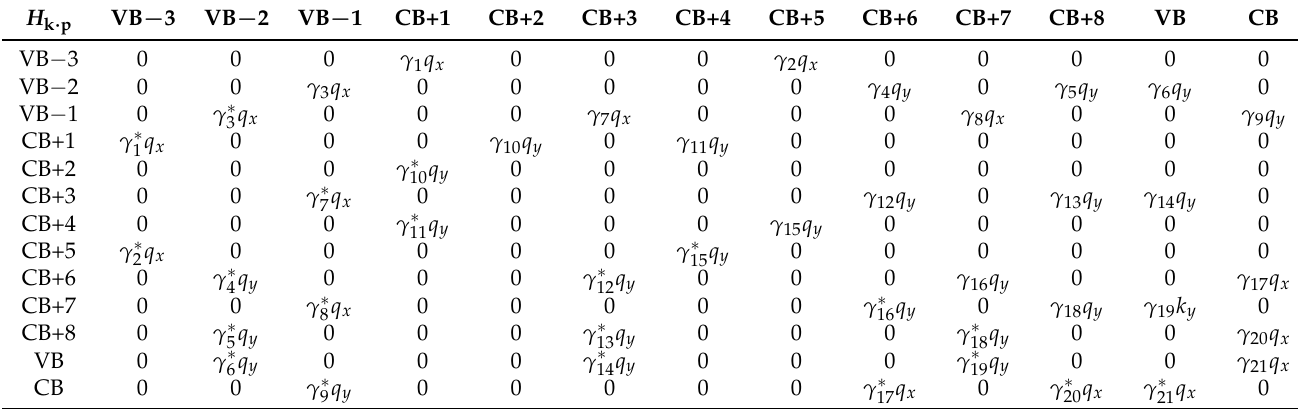
Table A6. k · p matrix elements at M